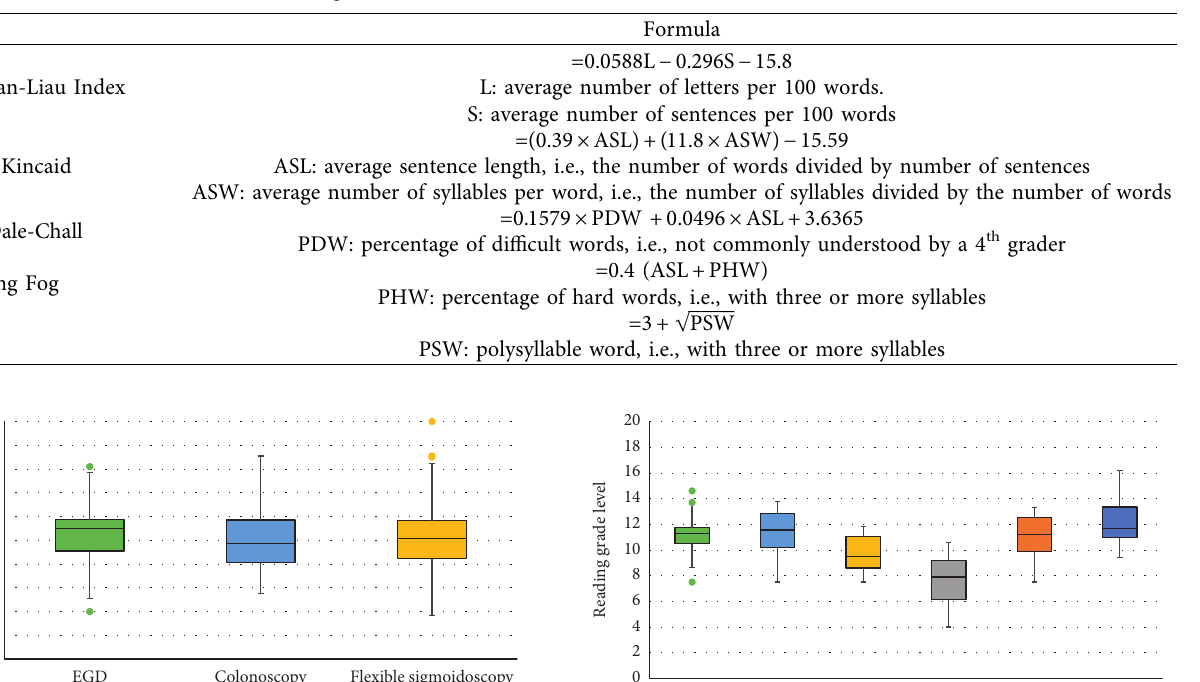
Table 1: The different formulas used to determine the reading grade levels of each study. An output of 6.5 would be the equivalent to someone who has finished half of their 6 th grade.